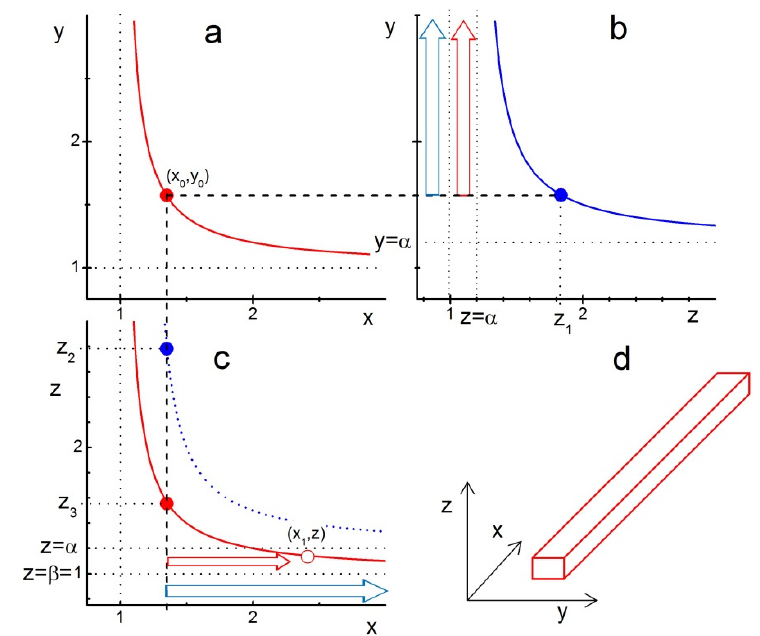
Figure 2. Illustration of ligand-assisted growth of a nanowire from model cuboid crystal with the anisotropy of LCN sizes L yz = α L xy and L xz = β L xy . The curves represent the boundary functions given by Equation (10): ( a ) y ( x ) , ( b ) y ( z ) , and ( c ) z ( x ) with the parameter values C = 0.2, α = 1.2, β = 1. The points ( x 0 , y 0 ) , ( z 1 , y 0 ) and ( x 0 , z 2 ) on the corresponding curves indicate the formation of a compact layer of ligands on the xy , zy and xz facets, respectively. The compact layer of ligands is supposed to be formed first at point ( x 0 , y 0 ) ; therefore, the z-edge of the crystal at this point has to be significantly lower than z max = min { z 1 , z 2 } . Blue arrows in ( b , c ) indicate the growth of nanoplatelets with z ≤ β = 1 similar to those in Figure 1. Red arrows in ( b , c ) indicate the growth of nanowires with α > z > β = 1, as in this z -range, the x -edge of the crystal grows until it reaches the red line at the point ( x 1 , z ) , indicating that the crystal’s xz -facet gets covered with a compact layer of ligands thus fixing the y -edge length. ( d ) A nanowire-like shape of the crystal growing with α > z > β = 1 after its xy - and xz -facets are covered with a compact layer of ligands. For z max > z > α , the growing x- and y -edges would intercept the corresponding border lines (blue in ( b ) and red in ( c )) and form a finite-sized